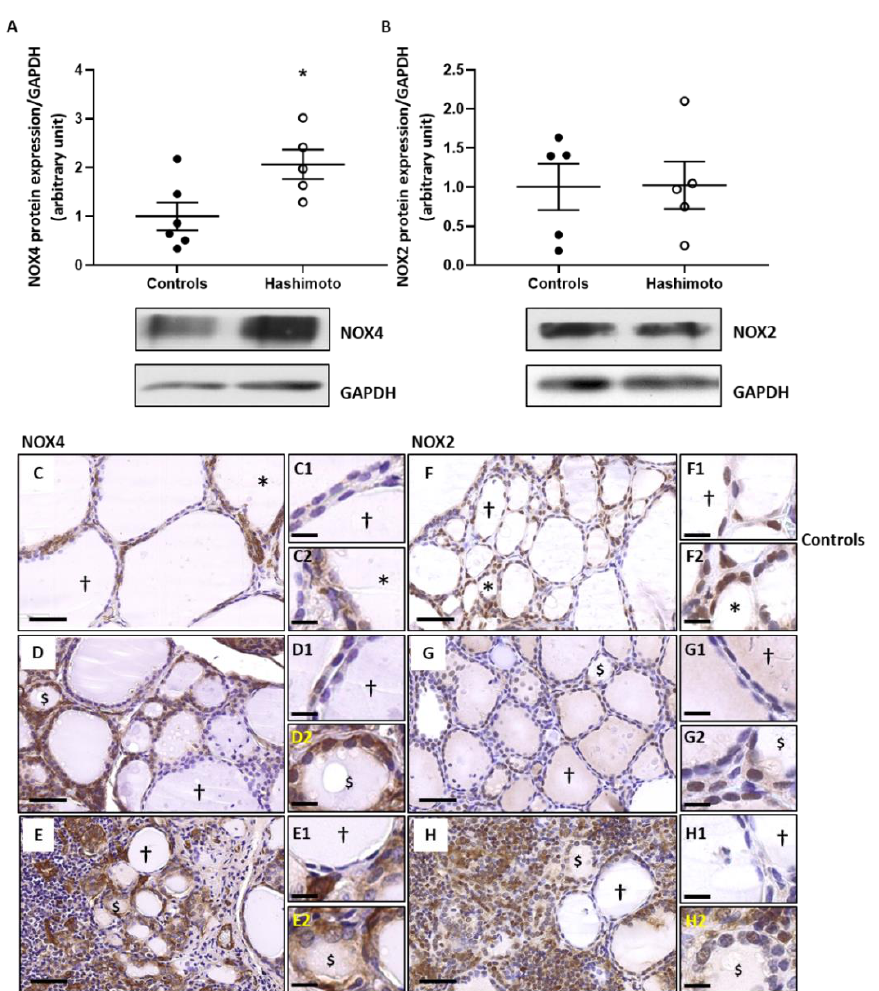
Figure 2. NOX4 protein expression was increased in Hashimoto’s thyroiditis (HT) thyroid samples while NOX2 did not change. Western blots performed on control and Hashimoto’s thyroiditis (HT) thyroid samples revealed a significant increase of NOX4 protein in HT ( A ), but no change in NOX2 ( B ). Densitometric values were normalized against Glyceraldehyde 3-phosphate dehydrogenase (GAPDH) level. Results are expressed as means ± SEM from five or six individual samples ( n = 5–6). * p < 0.05 compared to control. Representative blots are shown. Immunohistochemistry on paranodular tissue obtained from multinodular goiter patients designated as controls ( C , F ) and thyroid tissues from HT patients ( D , E , G,H ). The pictures illustrate representative tissue samples of both conditions. In control thyroids, the expression of NOX4 ( C ) and NOX2 proteins ( F ) was more intense in active follicles (*) than in hypofunctional follicles (†). In HT non-inflammatory zone, hypofunctional follicles (†) lightly expressed NOX4 ( D ) and NOX2 ( G ). In contrast, thyrocytes of altered active-like follicles ($) expressed strongly NOX4 in their cytoplasm ( D ) while NOX2 was moderately expressed ( G ). In HT inflammatory zones, the numerous altered active-like follicles ($) expressed elevated levels of NOX4 in the cytoplasm of their thyrocytes ( E ). NOX2 was highly expressed in inflammatory cells ( H ). ( C – H ) Scale bar = 50 µm. ( C1 – H2 ) Scale bar = 20 µm. 2.3. The Expression of PRDX1 and Catalase Is Decreased by Th1 Cytokines in Human Thyroid Cells and the Expression of Catalase Is Lowered in HT Thyroid Samples PRDX1 and catalase protein expression quantified by Western blotting were signifi- cantly decreased in primary cultures of human thyrocytes treated with Th1 cytokines (Fig- ure 3A,B). In thyroids of HT patients, PRDX1 protein expression was unchanged (Figure 3C) but catalase expression was significantly decreased as compared to controls (Figure 3D).